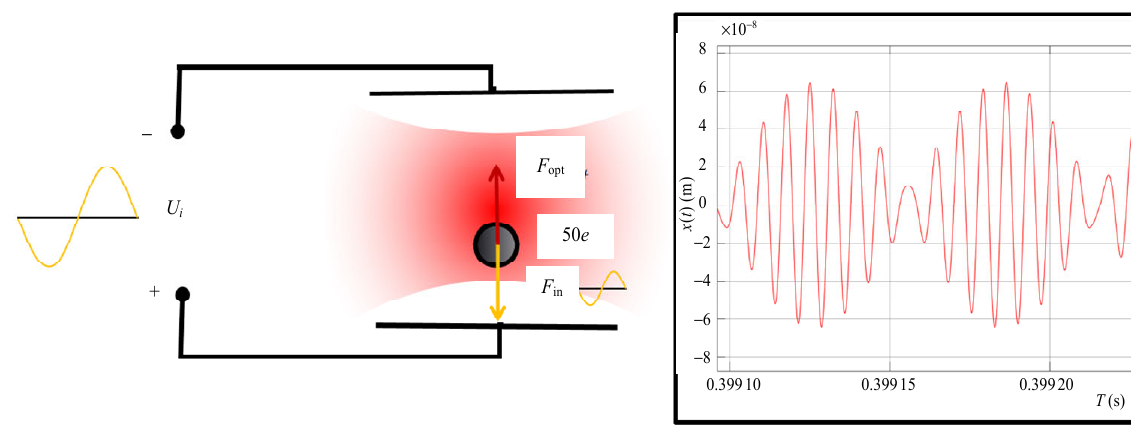
Fig. 4 Charged particle and electric field in the capturing region.